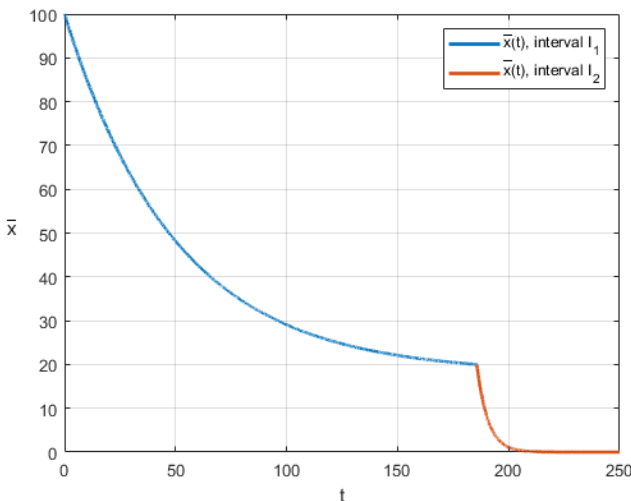
Figure 6. Optimal cooperative trajectory for state-dependent